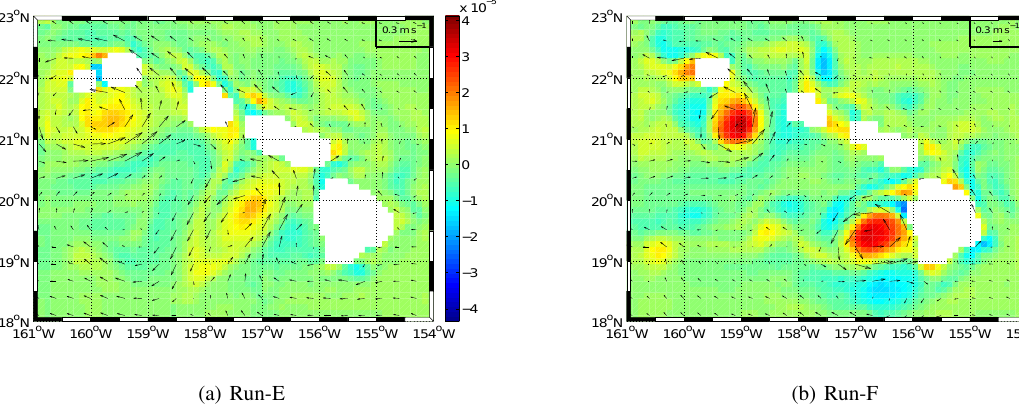
Fig. 8. Relative vorticity field with velocity vectors at 10-m depth on 25 August for Run-E (left) and Run-F (right). Table 2. Features of the cyclones based on statistics for the last 5yr of each simulation and for Opal (n.d. stands for not determined). Run-A Run-B Run-C Run-D Run-E Run-F Opal σ t σ t σ t σ t σ t Isopycnal outcropping σ t 23 . 6 23 . 6 23 . 6 23 . 6 / 23 . 8 23 . 6 / 23 . 8 23 . 6 / 23 . 8 160 ± 10 n.d. Velocity (ms − 1 ) 0 . 24 ± 0 .